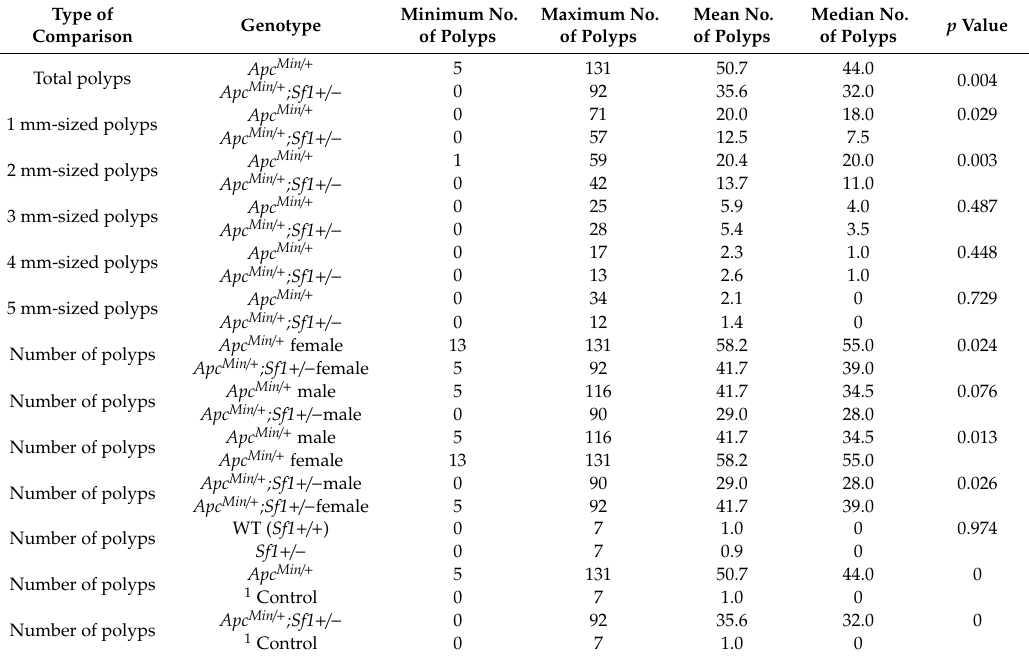
Table 2. Summary of polyp numbers and results from Mann–Whitney